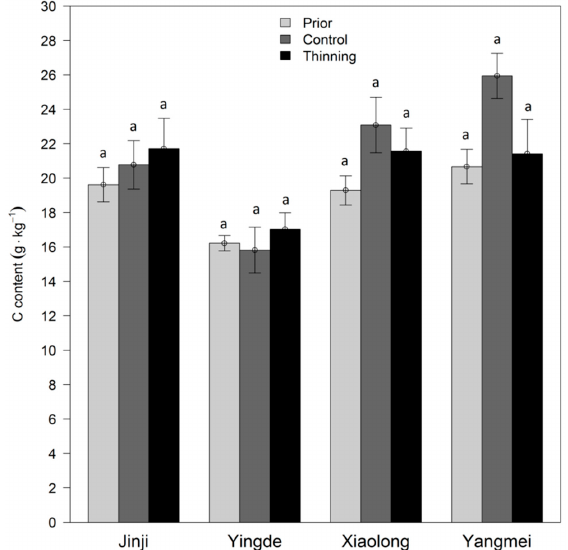
Figure 4. Carbon contents in the mineral soil (0–10 cm) in 2020 (Prior),and unmanaged plots (control), and thinning plots (thinning) in 2021. Error bars are standard errors of estimates. Significant differences between treatments in the same study site are indicated by different letters ( p < 0.05). The same letter “a” means there are no significant differences. The N contents in the mineral soil decreased significantly in Yangmei (Figure 5) and increased in Xiaolong. In 2020, before thinning was applied, the highest N contents in the mineral soil were found in Yangmei (2.09 g·kg − 1 ); however, in 2021, in control plots, the highest N contents were found in Xiaolong (2.06 g·kg − 1 ). In Jinji, Yingde, and Xiaolong, the N content of thinning plots decreased less than that of control plots.